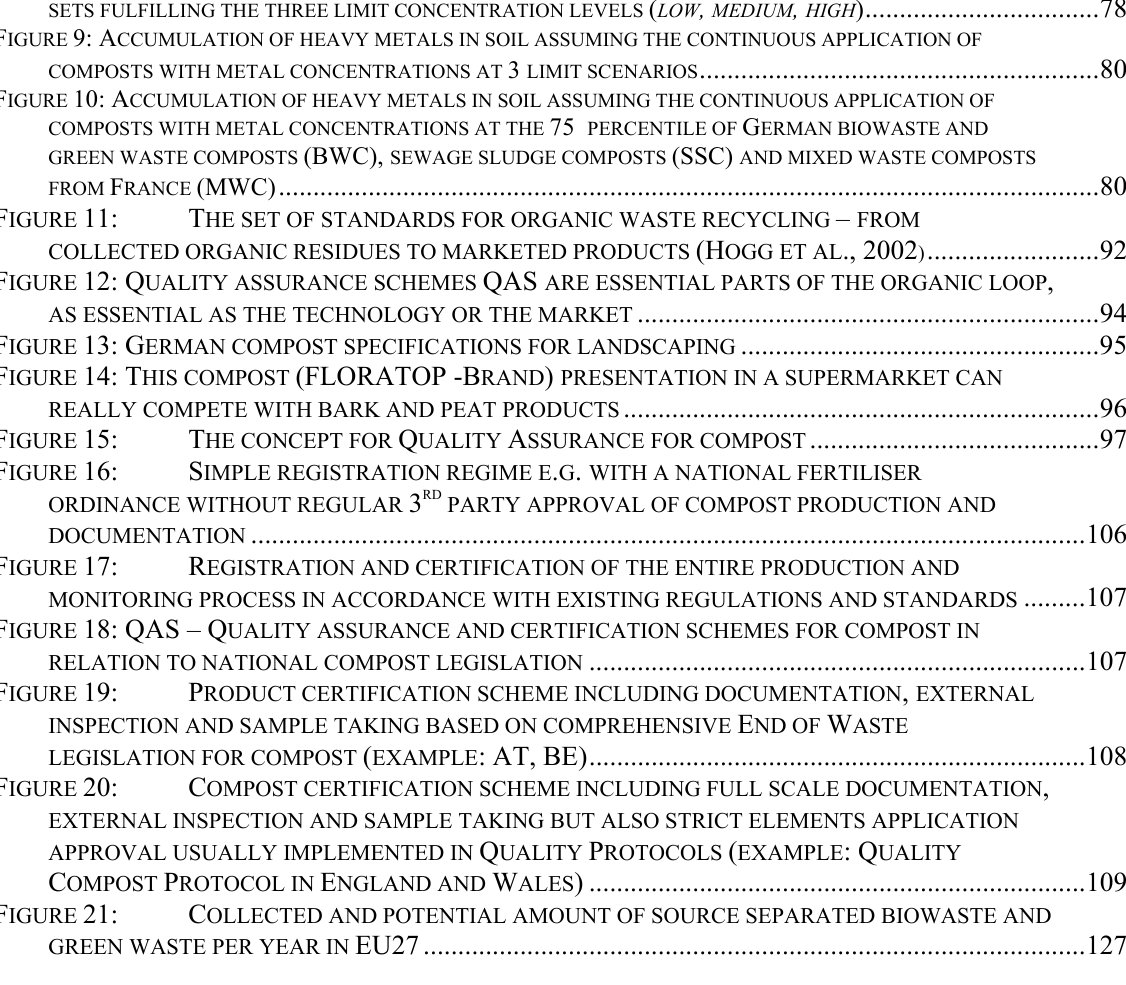
F IGURE 2. C OEFFICIENT OF V ARIATION OF LABORATORY MEAN VALUES [CV(MEAN LAB )] BETWEEN PARTICIPATING LABORATORIES OF FRESH SAMPLES VS . CONCENTRATION LEVELS OF HEAVY METALS ; F IGURE 3: C OEFFICIENT OF V ARIATION OF LABORATORY MEAN VALUES [CV(MEAN LAB )] BETWEEN PARTICIPATING LABORATORIES OF 6 G ERMAN AND A USTRIAN INTER - LABORATORY TRIALS 1993 - 2001 AND IN THE CEN TC 223 ILT FOR THE E UROPEAN STANDARD EN 13650: S OIL IMPROVERS AND F IGURE 4: E XAMPLE FOR THE MATHEMATICAL INCREASE OR DECREASE OF METAL CONCENTRATION RELATED TO A STANDARD ORGANIC MATTER CONTENT (30 % OM) WITH VARYING ACTUAL OM LEVELS IF THE CONCENTRATION IN THE ORIGINAL SAMPLE IS ANALYSED WITH 200 MG / KG D . M ...................................................................................................67 F IGURE 5: D ISTRIBUTION OF HEAVY METAL CONCENTRATIONS IN BWC, SSC, MWC ( LEFT ) AND GWC ( RIGHT ) FROM SEVERAL NATIONAL INVESTIGATIONS AND DATA SETS IN RELATION TO THE ASSUMED THREE LEVELS OF HEAVY METAL LIMITS ..........................................75 F IGURE 6: P ERCENTAGE OF BIOWASTE, SEWAGE SLUDGE (SSC) AND MIXED WASTE (MWC) COMPOST SAMPLES FROM DE, NL, AT, C ATALONIA (C ATAL .) AND FR DATA SETS WITHIN THE ASSUMED THREE LIMIT CONCENTRATION LEVELS ( LOW , MEDIUM , HIGH )..........77 F IGURE 7: P ERCENTAGE OF GREEN WASTE COMPOST SAMPLES FROM DE, NL AND AT DATA SETS WITHIN THE THREE ASSUMED LIMIT CONCENTRATION LEVELS ( LOW , MEDIUM , HIGH )..........77 F IGURE 8: P ERCENTAGE OF FRESH ( N =779) AND MATURE ( N =1955) COMPOST SAMPLES FROM DE, DATA SETS FULFILLING THE THREE LIMIT CONCENTRATION LEVELS ( LOW , MEDIUM , HIGH ) ..................................78 F IGURE 9: A CCUMULATION OF HEAVY METALS IN SOIL ASSUMING THE CONTINUOUS APPLICATION OF COMPOSTS WITH METAL CONCENTRATIONS AT 3 LIMIT SCENARIOS ..........................................................80 F IGURE 10: A CCUMULATION OF HEAVY METALS IN SOIL ASSUMING THE CONTINUOUS APPLICATION OF COMPOSTS WITH METAL CONCENTRATIONS AT THE 75 PERCENTILE OF G ERMAN BIOWASTE AND GREEN WASTE COMPOSTS (BWC), SEWAGE SLUDGE COMPOSTS (SSC) AND MIXED WASTE COMPOSTS FROM F RANCE (MWC) .......................................................................................................................80 F IGURE 11: T HE SET OF STANDARDS FOR ORGANIC WASTE RECYCLING – FROM COLLECTED ORGANIC RESIDUES TO MARKETED PRODUCTS (H OGG ET AL ., 2002 ) .........................92 F IGURE 12: Q UALITY ASSURANCE SCHEMES QAS ARE ESSENTIAL PARTS OF THE ORGANIC LOOP ,